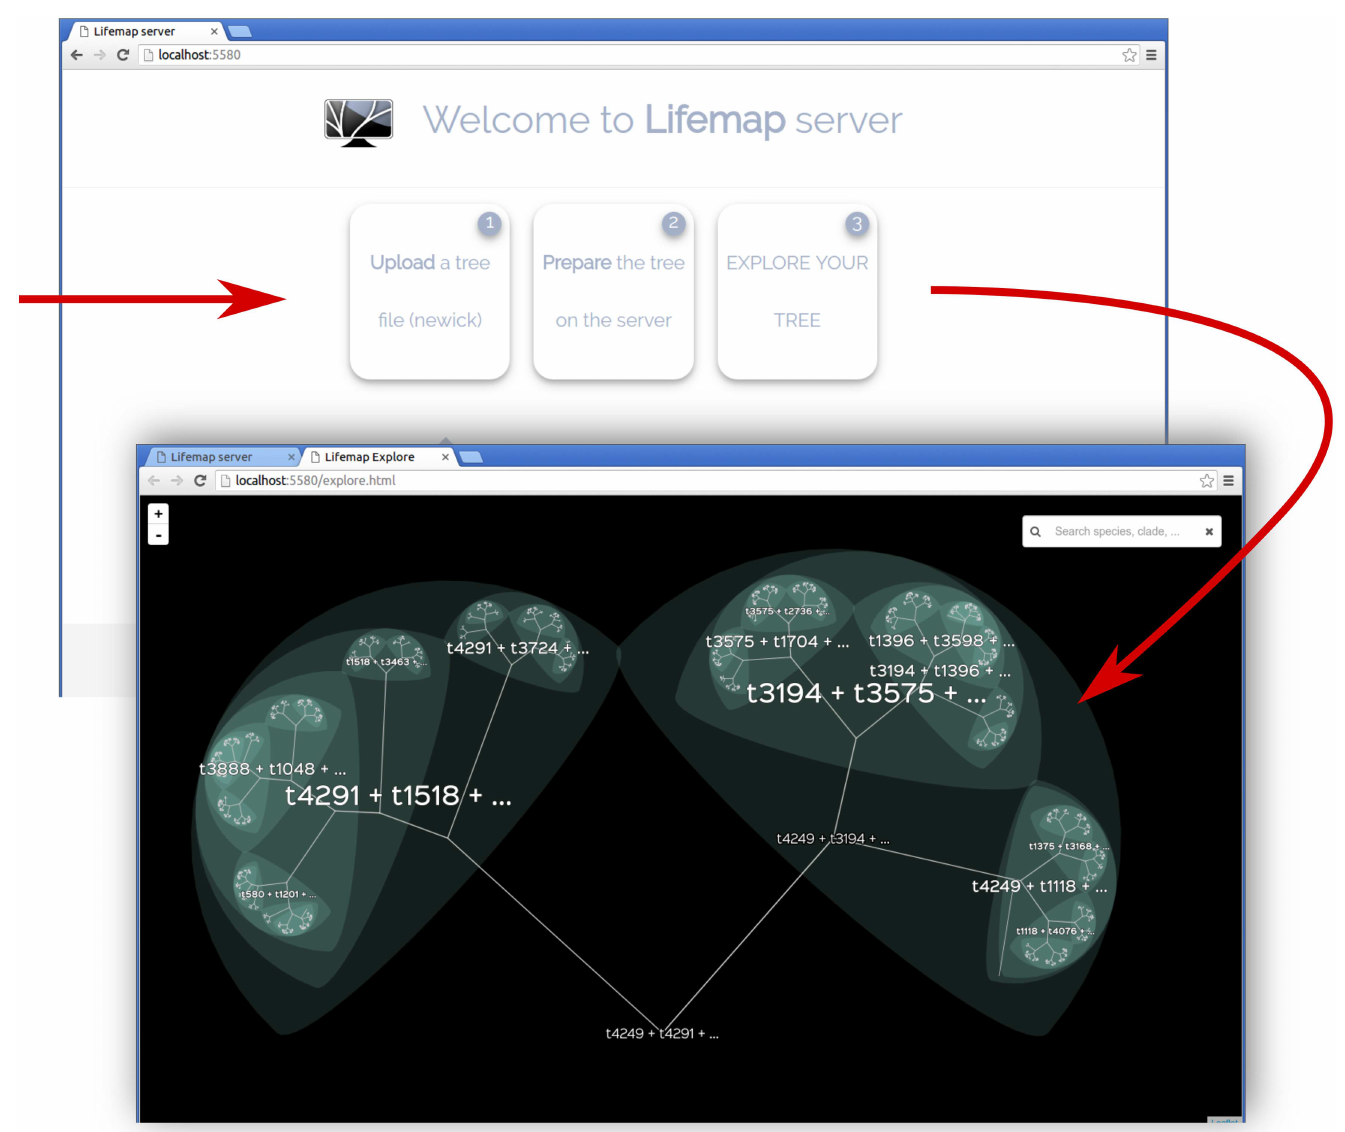
Fig 3. Screenshots of the Lifemap server. Visualizing a tree with the Lifemapserver is a three-step process that is performed from the dedicatedweb page (top screen). Once the tree file has been uploadedand the computations have been performed, the tree can be explored(bottom screen). This last screenshotshows the appearance of Lifemapfor a fully bifurcatingtree with nodesautomatically named(see